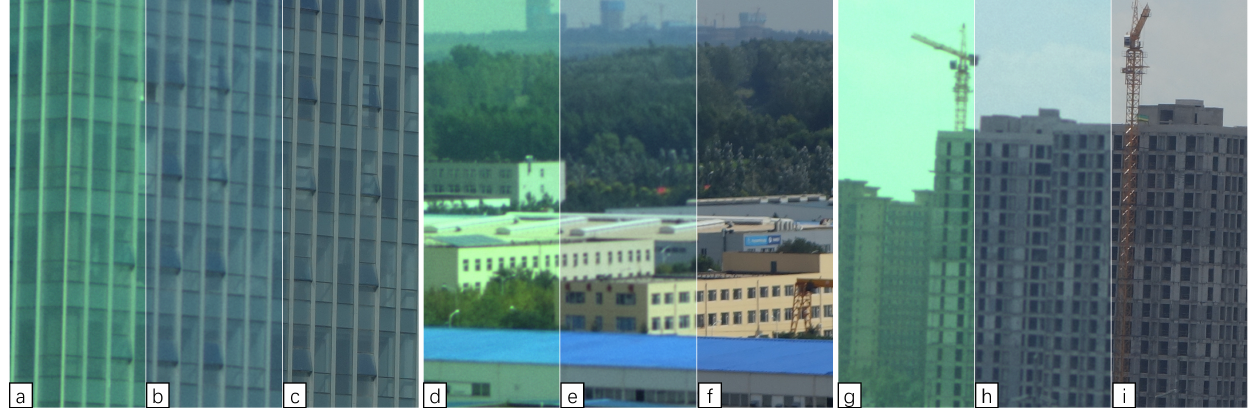
Figure 9. ( a , d , g ) are the original images captured by the detector; ( b , e , h ) are the paths of 25 regions replaced with a 1-block area; ( c , f , i ) are the results of normal processing by the DDZMR network model. A quantitative comparison of the Ablation testing is shown in Table 1. Peak Signal to Noise Ratio (PSNR) and Structural Similarity (SSIM) enable quantitative objective evalua- tion of reconstructed images. PSNR mainly evaluates the ratio of the maximum